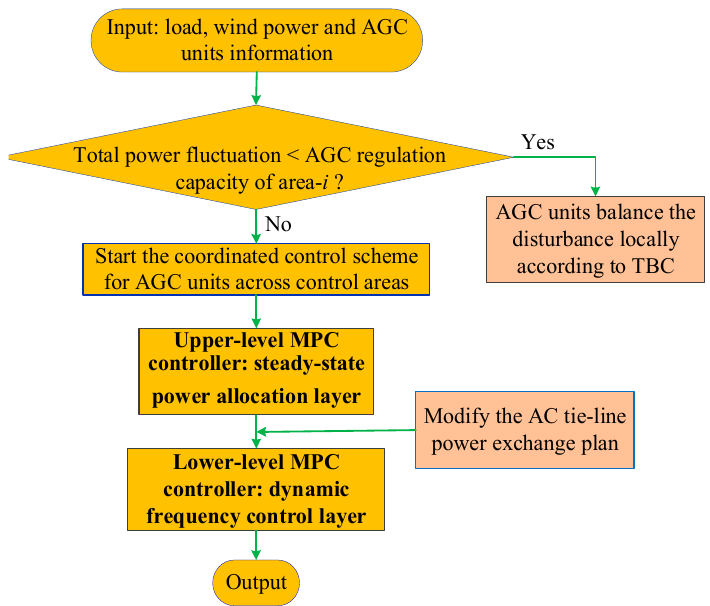
Figure 4. Coordinated control scheme for AGC units with wind farm across control areas.